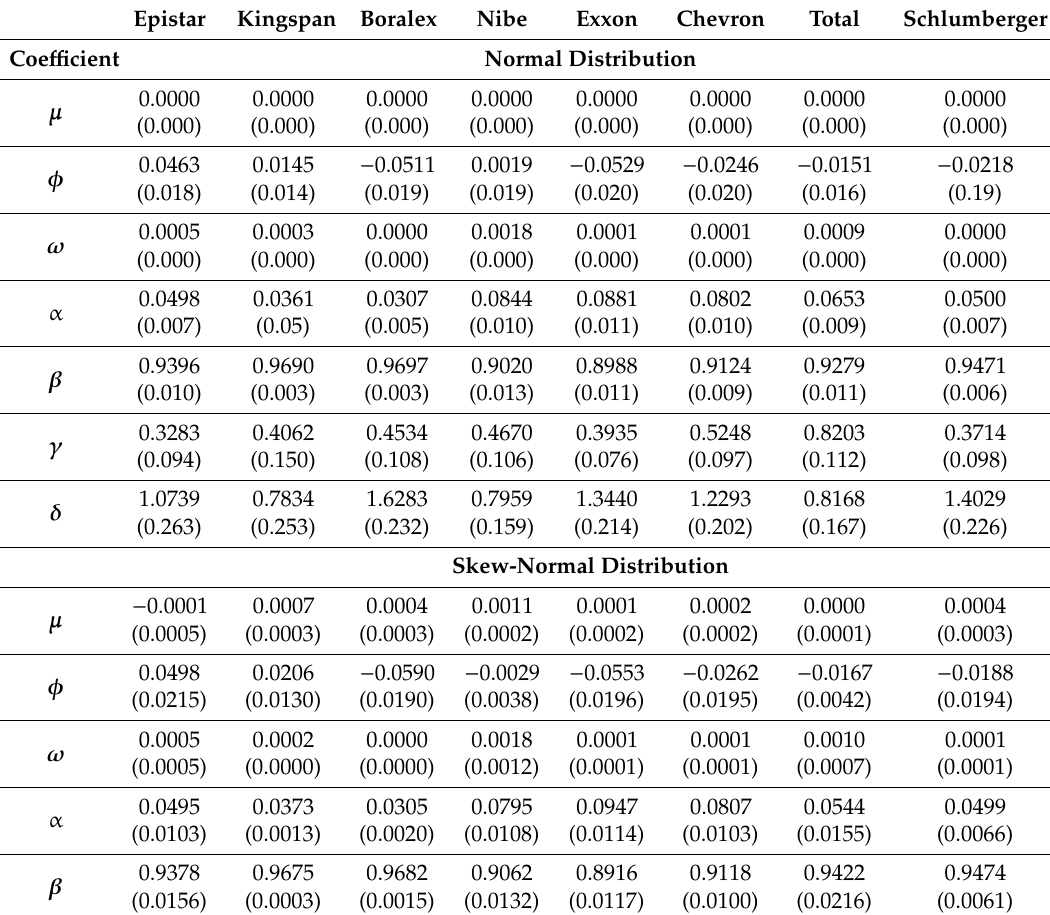
Table A4. Estimation of the AR(1)-APARCH(1,1)